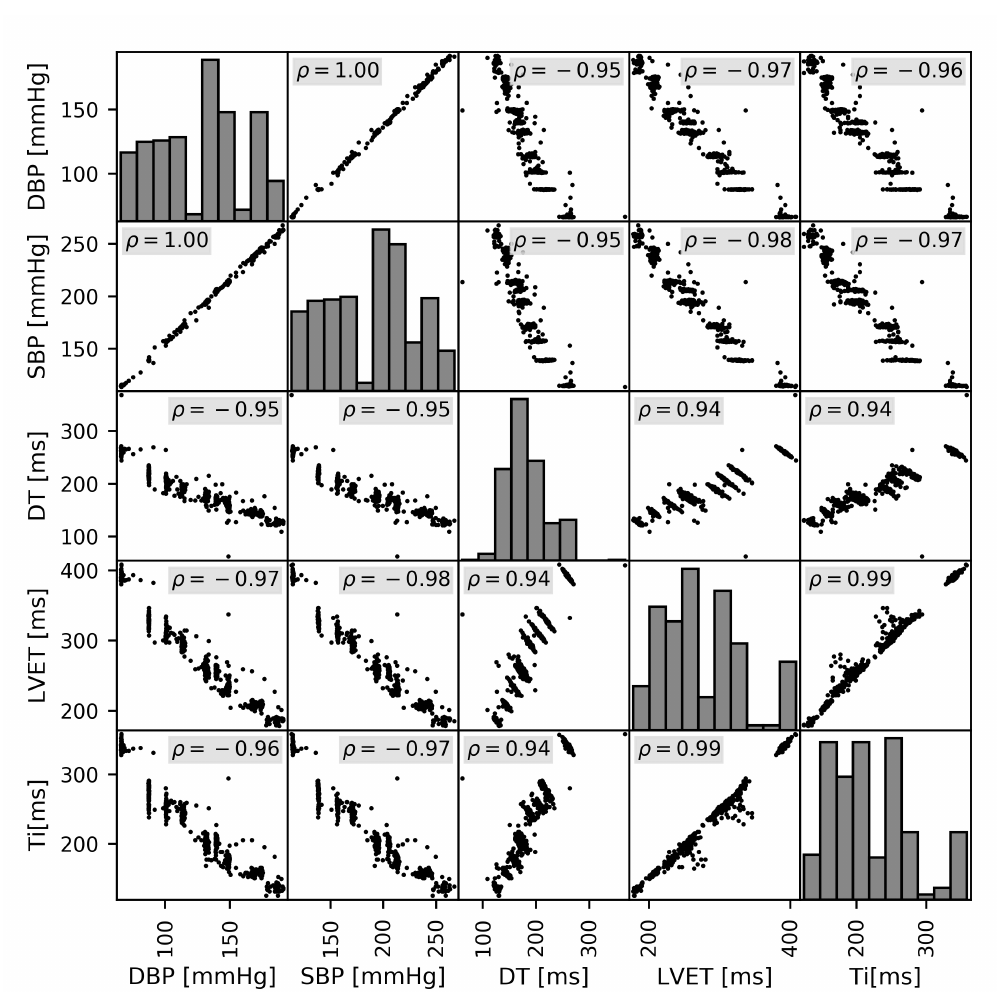
Figure 5. Correlations between the investigated temporal and spatial variables together with Rho values.